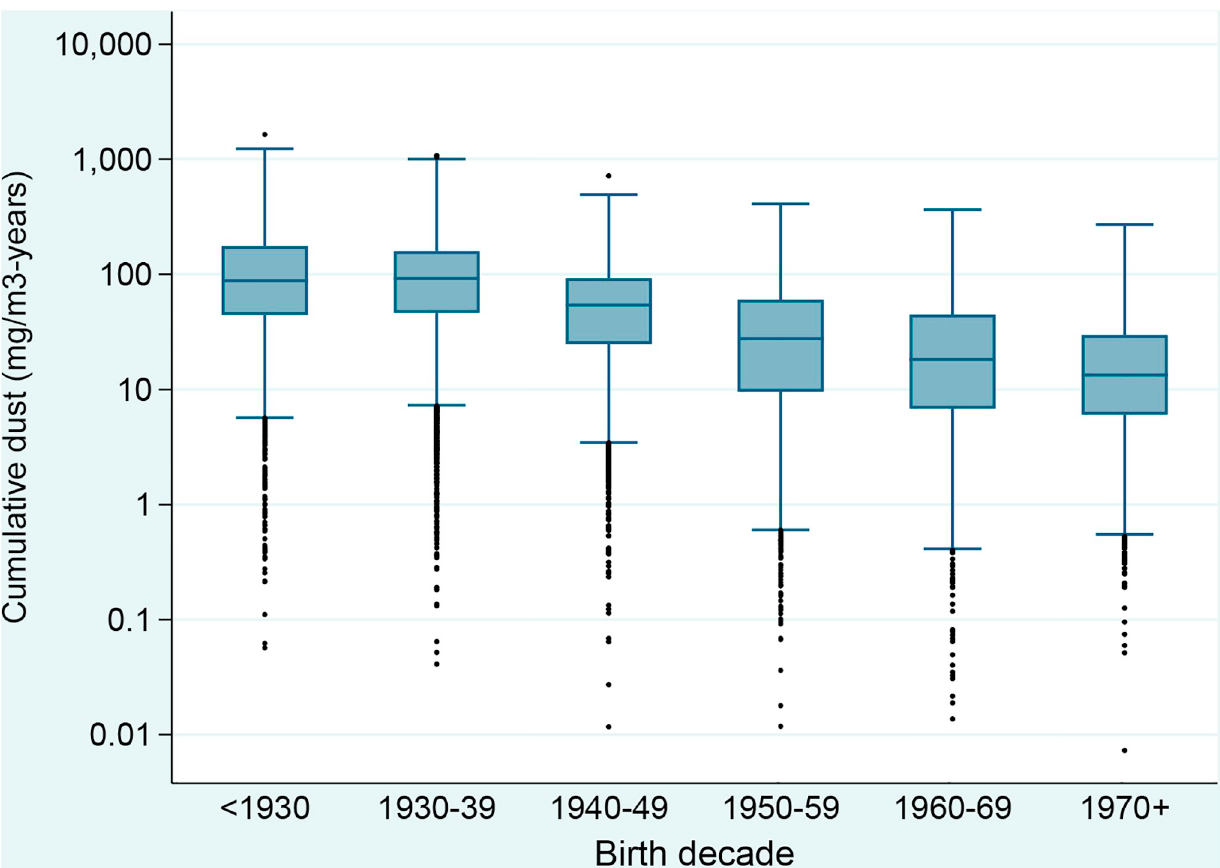
Fig 4. Box plot of cumulative exposure to dust (mg/m 3 -years) of workers in the Asbest Chrysotile Cohort study, by birth decade. The dark line in the middle of the boxes represents the median, the bottom of the box indicates the 25 th percentile, and the top of the box represents the 75 th percentile.